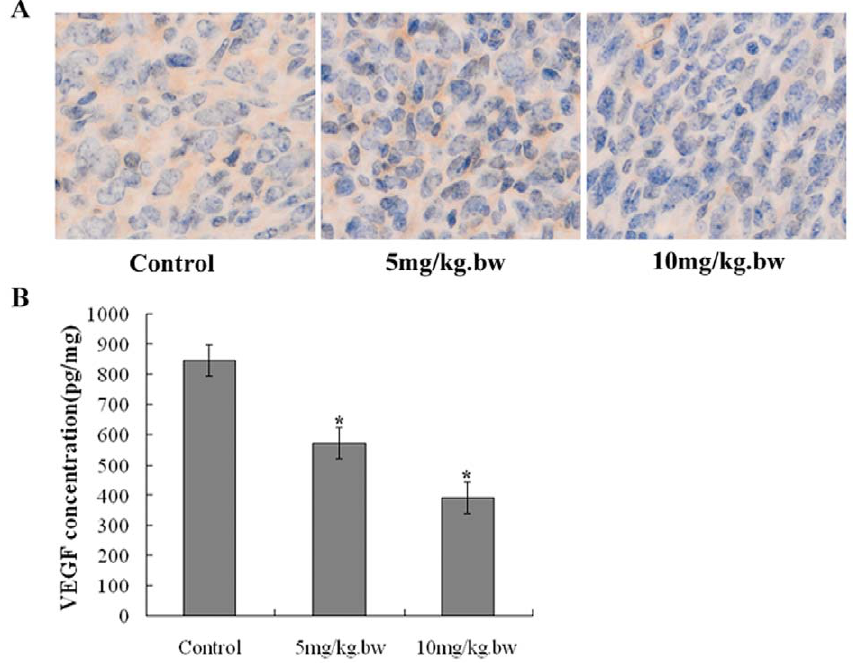
Figure 8. Fucoidan down-regulated VEGF expression in vivo. A) Representative photographs of the tumor sections examined by immunohistochemical staining for VEGF ( 6 00 magnification). The assessment of VEGF was based on a cytoplasmic staining pattern. B) The tumors were harvested and assayed for VEGF protein by ELISA. The results are presented as mean 6 SD (n=7 tumors). Fucoidan caused significant reduction in intratumoral VEGF expression compared with control group. * P , 0.05 vs Control.